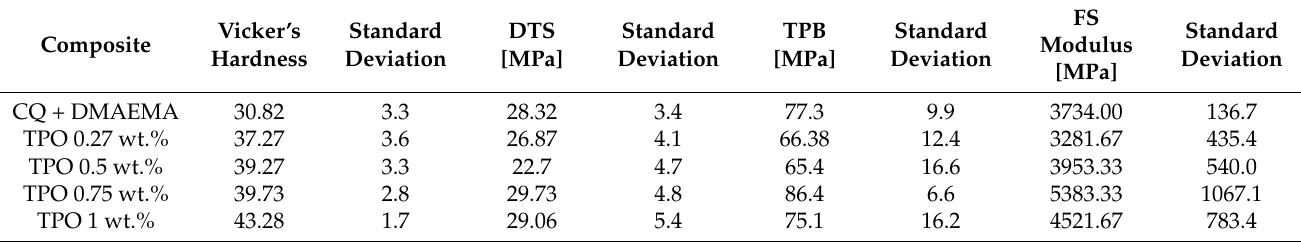
Table A1. Median values of Vicker’s hardness, diametral tensile strength (DTS), three-point bending flexural strength (TPB), and modulus of elasticity in bending (FS modulus) with standard deviation for tested